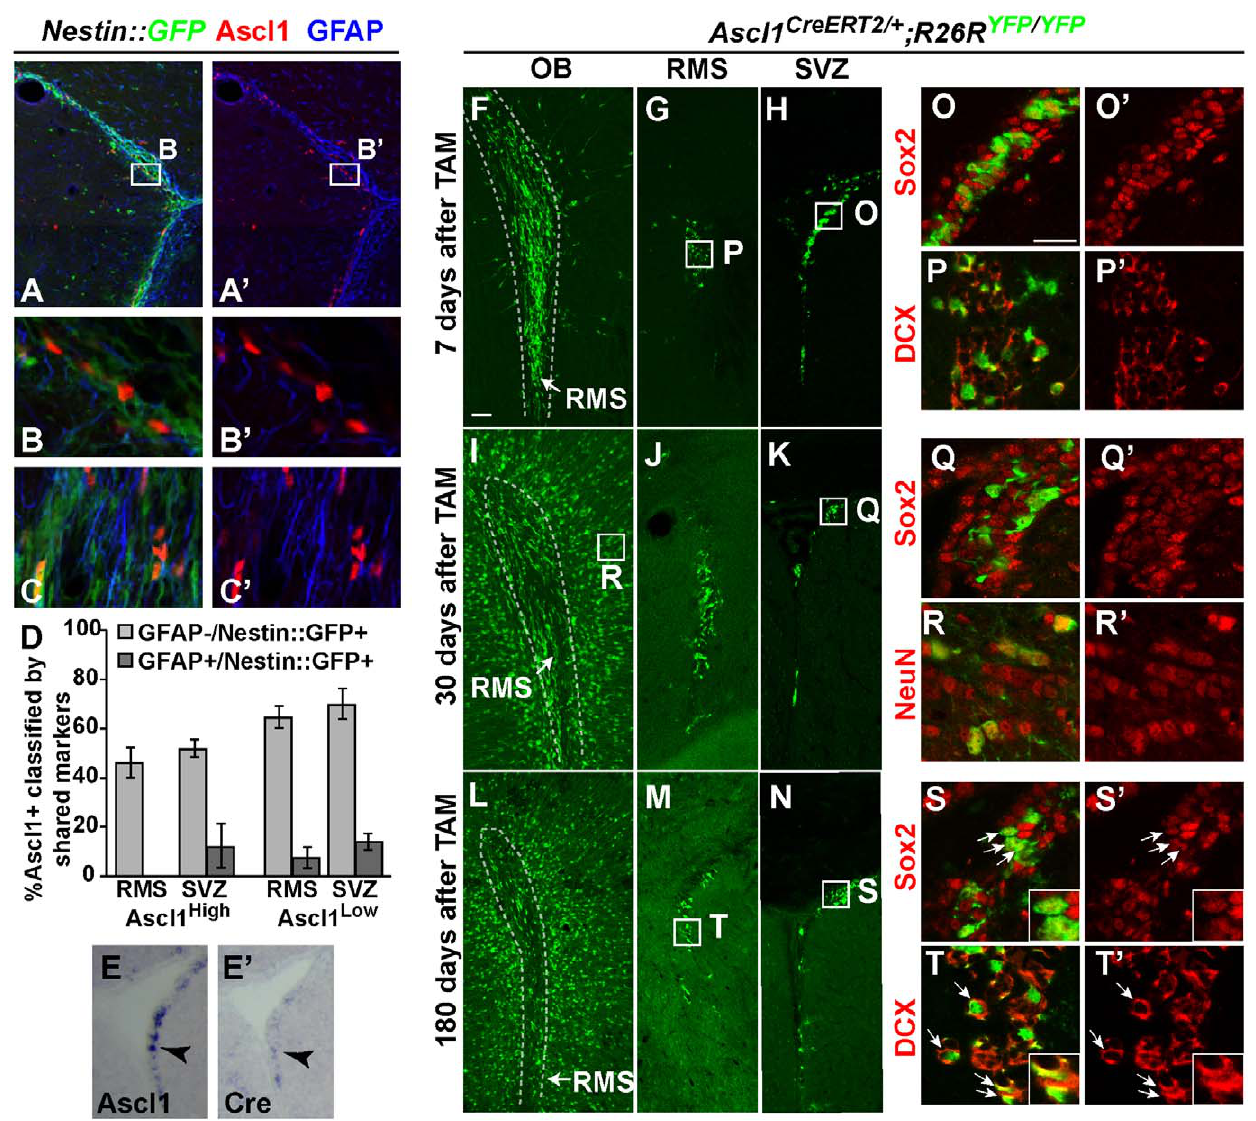
Figure 3. A subset of Ascl1 lineage cells in adult SVZ have long term self renewing properties in the generation of olfactory bulb neurons. (A–D) Ascl1 is detected in Nestin::GFP + GFAP + cells (B cells) in the SVZ (A–B 9 ) and in Nestin::GFP + GFAP 2 C cells in SVZ (A–B 9 ) and RMS (C,C 9 ) in 8 week old Nestin::GFP transgenic mice. (D) Percentage of Ascl1 High or Ascl1 Low cells that express the markers Nestin::GFP and GFAP (dark shaded bars) or just Nestin::GFP (grey shaded bars) in the RMS and the SVZ. 25 Ascl1 + cells per mouse were counted in the RMS; 60 Ascl1 + cells per mouse in the SVZ, n=3 Nestin::GFP mice. (E–E 9 ) mRNA in situ with Ascl1 (E) or Cre (E 9 ) probes in the adult SVZ. (F–T 9 ) Immunofluorescence in Ascl1 CreERT2/ + ; R26R YFP/YFP mouse brain sections harvested 7, 30, or 180 days post-TAM demonstrates Ascl1 derived cells along the SVZ-RMS-OB pathway (F–N). 7 days post-TAM most YFP + cells were located in the SVZ, or along the RMS (F–H) and express Sox2 (O–O 9 ) or DCX (P–P 9 ). 30 or 180 days post-TAM YFP + cells mature into neurons in the granule cell layer or the periglomerular layer of the OB (I, L, R–R 9 , and data not shown). However, many YFP + cells remain as Sox2 + or DCX + progenitors in the RMS or SVZ (J–K, M–N, Q–Q 9 , S–T 9 ). Scale bars =50 m m (F–N), 10 m m (O–T 9 ).